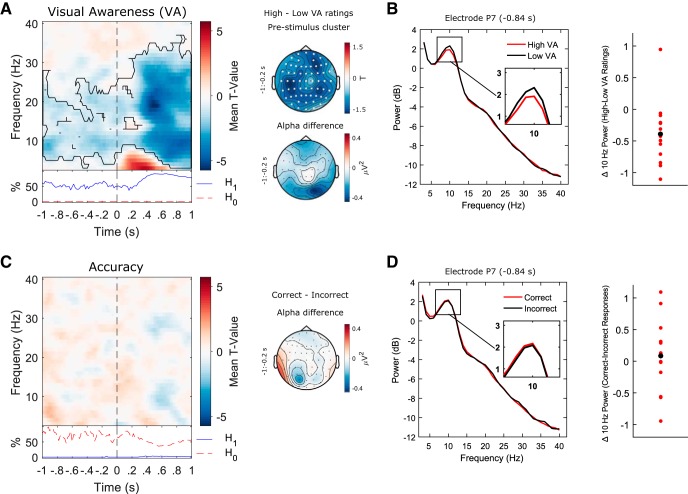
Relationship between oscillatory power and perception. A, The results of a single-trial regression analysis revealed that prestimulus power was negatively correlated with visual awareness ratings (i.e., high power was associated with low PAS ratings and low power with high PAS ratings, black contour denotes significant cluster-corrected effects; p < 0.05). Stimulus onset is highlighted by a vertical black dashed line. The bottom inset plots the time course of the percentage of electrode-frequency points within the significant cluster with BFs showing evidence for the null (H0: no EEG/awareness relationship; dashed red line) and alternative hypotheses, respectively (H1: significant EEG/awareness relationship; solid blue line). As expected, the percentage of data points providing evidence for H1 far outnumbered those providing evidence for H0. The prestimulus effect was widely distributed over all electrodes as indicated by the topographical representation of the effect (upper right panel; electrodes included in the significant cluster are highlighted in white). The lower right panel plots the scalp topography of the group-average difference in prestimulus α (8–14 Hz) power between high PAS rating (ratings 2 and 3) trials and low PAS rating (ratings 0 and 1) trials. B, Group-averaged frequency spectra computed separately for high PAS rating trials (red lines) and low PAS rating trials (black lines). Compared to low PAS rating trials, high PAS rating trials were associated with decreased prestimulus α power. This effect was highly consistent across participants as shown by the scatterplot (right panel; black dot represents the mean difference value) of the difference in mean 10-Hz power between high and low PAS rating trials for each participant. C, No relationship was found between EEG power and discrimination accuracy in any of the time-frequency ranges examined. The bottom inset plots the time course of the percentage of electrode-frequency points from the significant EEG/awareness cluster with BFs showing evidence for the null (H0: no EEG/accuracy relationship; dashed red line) and alternative hypotheses, respectively (H1: significant EEG/accuracy relationship; solid blue line). The percentage of data points providing evidence for H0 far outnumbers those providing evidence for H1. The right panel plots the scalp topography of the difference in prestimulus α power between correct and incorrect trials. D, Group-averaged frequency spectra computed separately for correct (red lines) and incorrect trials (black lines). No difference in power was observed between correct and incorrect trials. The right panel plots the difference in mean 10-Hz power between correct and incorrect trials for each participant (black dot represents the mean difference value).